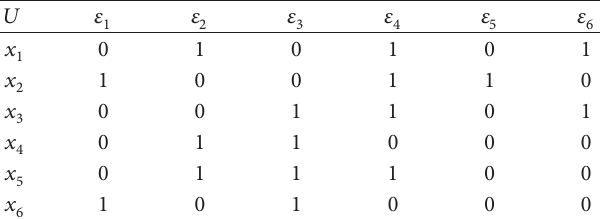
Table 1: Tabular representation of (𝐹, 𝐴) .